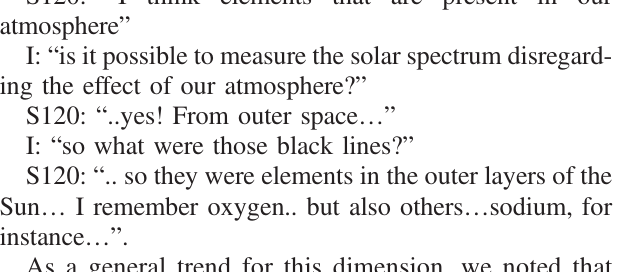
FIG. 13. Sample 3 student post-instruction sketch of forces acting on a small volume element of the Sun. Translation of Italian label: P ¼ Pressure in the core; F ¼ S113: “… I am not sure … but I think that the new force can only be related to nuclear reactions … . ”